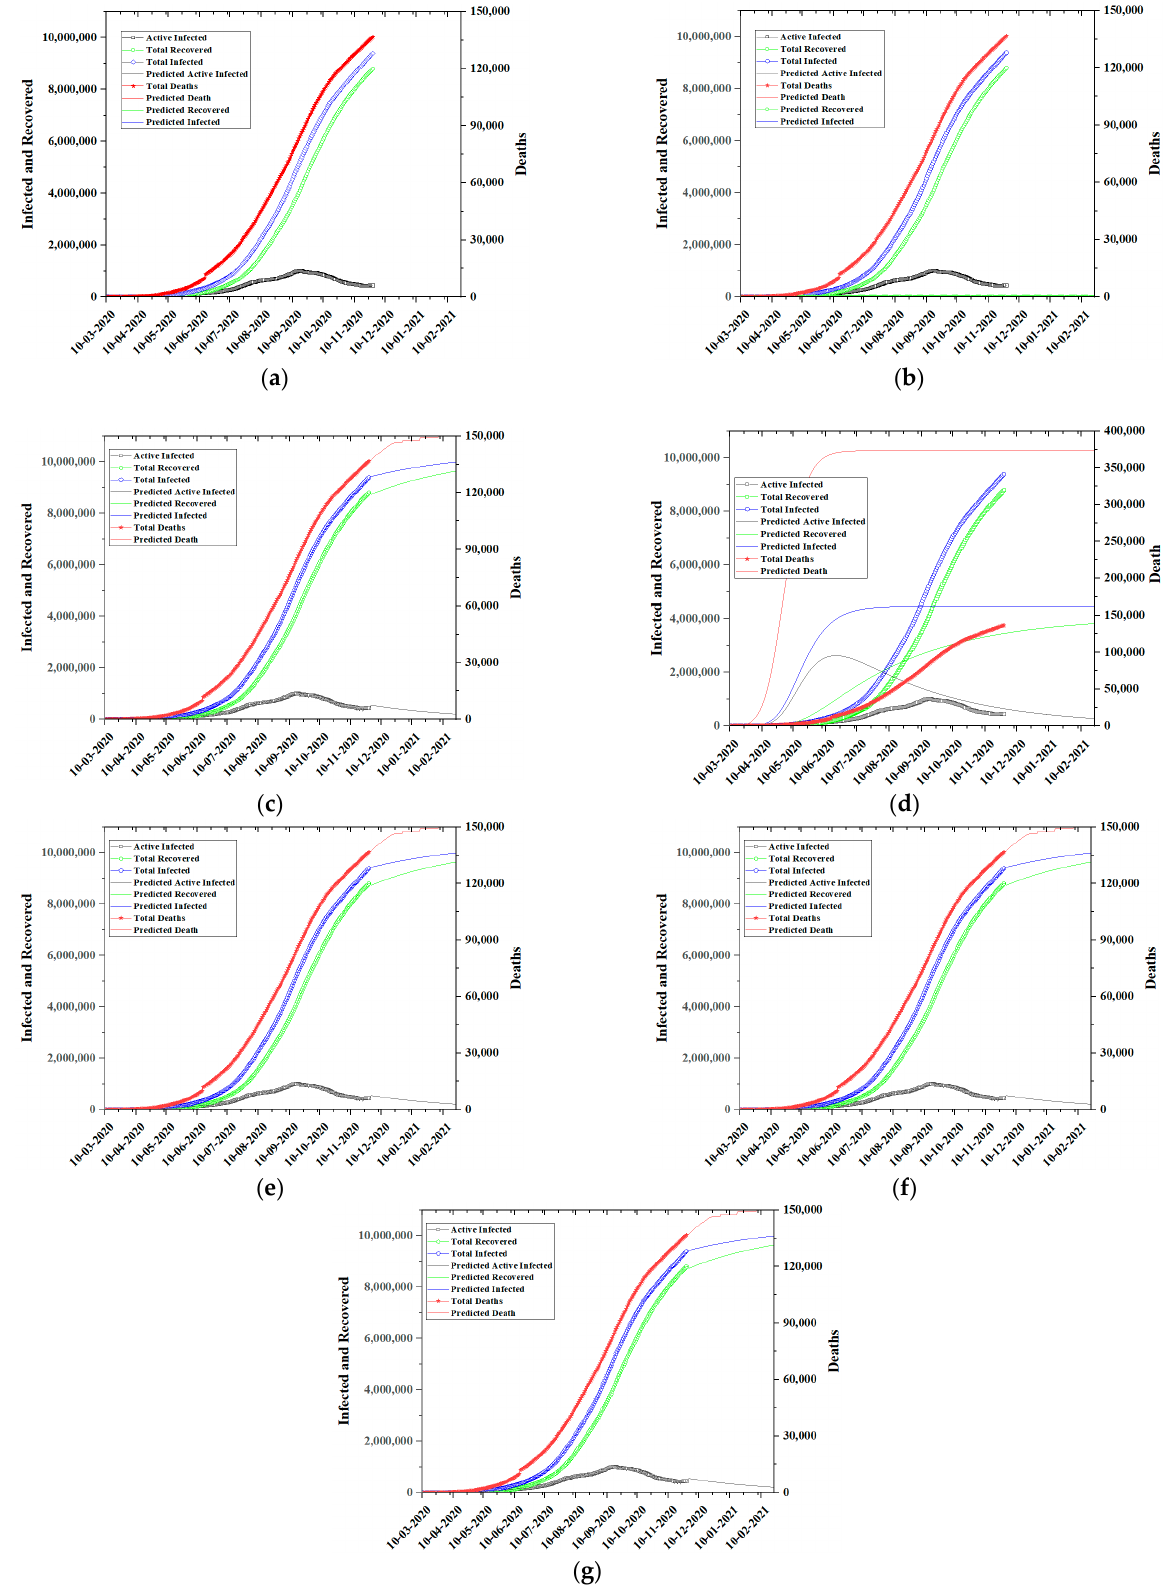
Figure 8. Prediction curve of Indian COVID-19 using ( a ) G ( b ) PS ( c ) PSO ( d ) G + PS ( e ) G + PSO ( f ) G + PS + G ( g ) G + PSO + G.